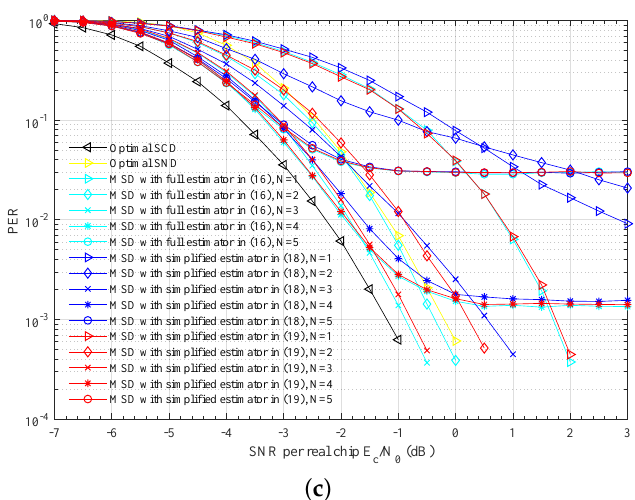
Figure 4. Detection performance impact of the truncated number N of differential chips under the proposed MSD scheme over a pure AWGN channel when the observation window length j = 2. ( a ) PER performance with full estimator in (16); ( b ) PER performance with simplified estimator in (18); ( c ) PER performance with simplified estimator in (19).